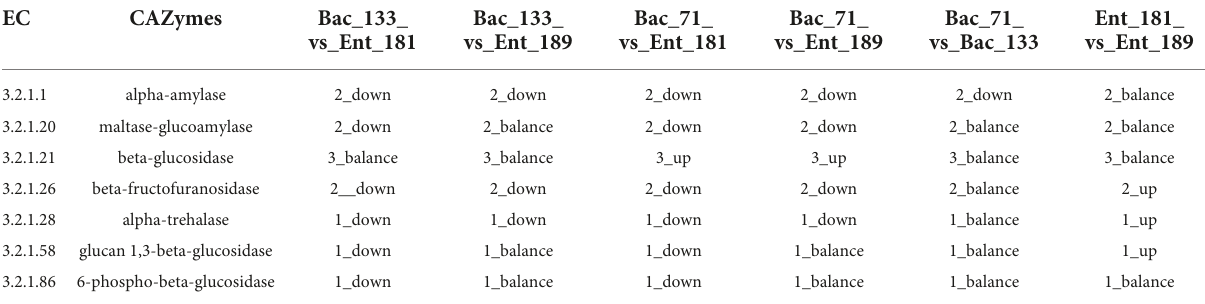
TABLE 4 The identified differential expression level for the lignocellulose genes using the transcriptomic analysis.